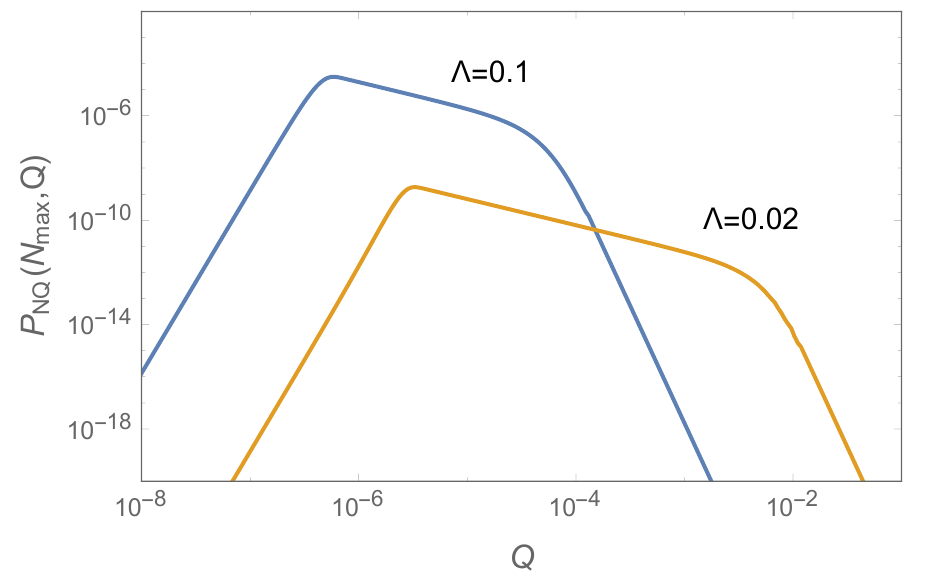
Figure 3 . P NQ ( N max ; Q ) as a function of Q . We assume N max = 120, N CMB = 50, U 0 = 10 (cid:0) 19